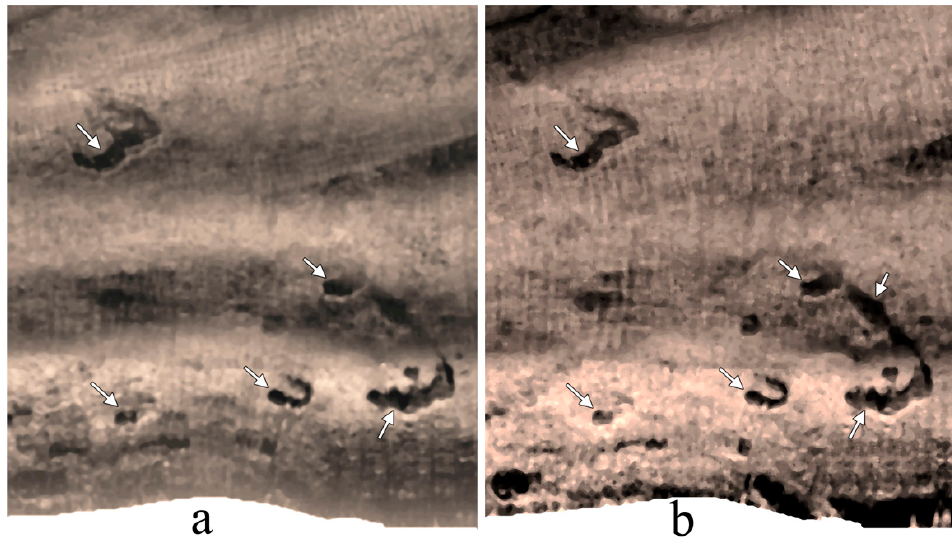
Figure 15. Sonograph of ( a ) 400 and ( b ) 100 kHz showing representative dense, almost continuous and uniform P. oceanica meadows. Arrows indicate sand gaps inside P. oceanica meadow.